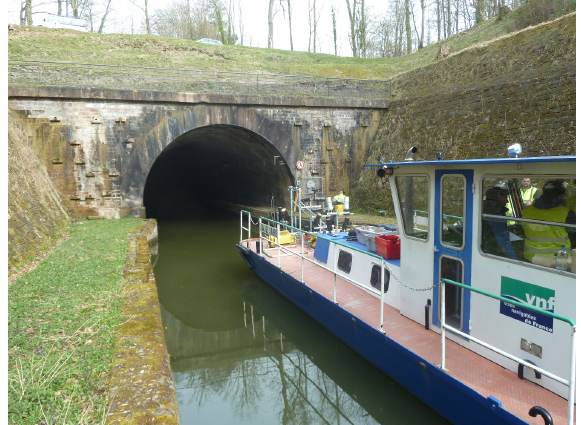
Figure 1. View of the barge supporting the modular acquisition system, on the experimental